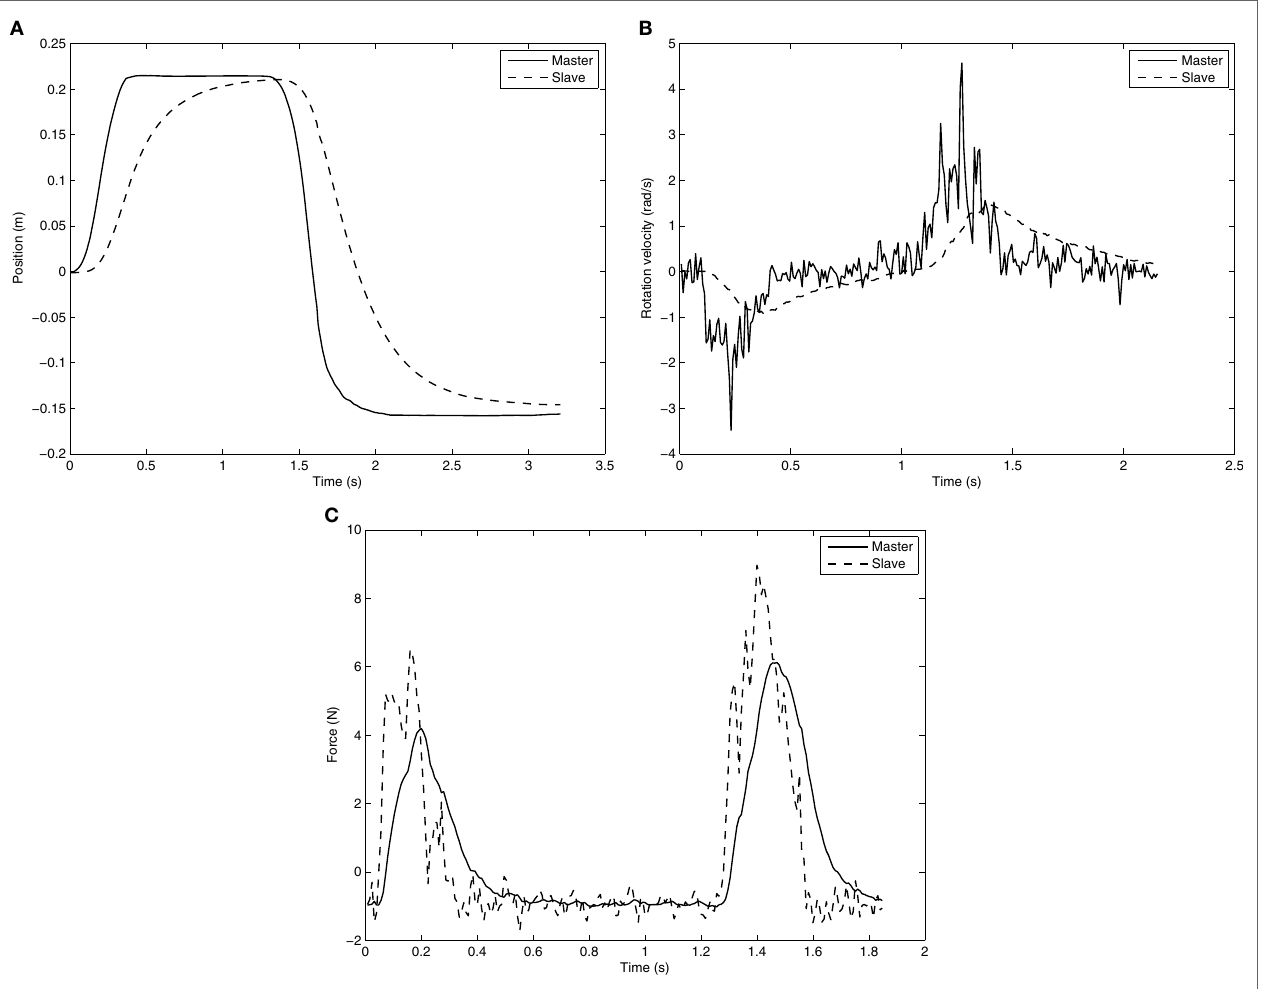
FigUre 10 | Master and slave position, rotation velocity, and force. Each subfigure is a separate experiment. (a) Master and slave position when the master creates a step-like input. (B) Master and slave rotation velocity when the master creates an impulse-like input. (c) Master and slave force when the master creates an impulse-like